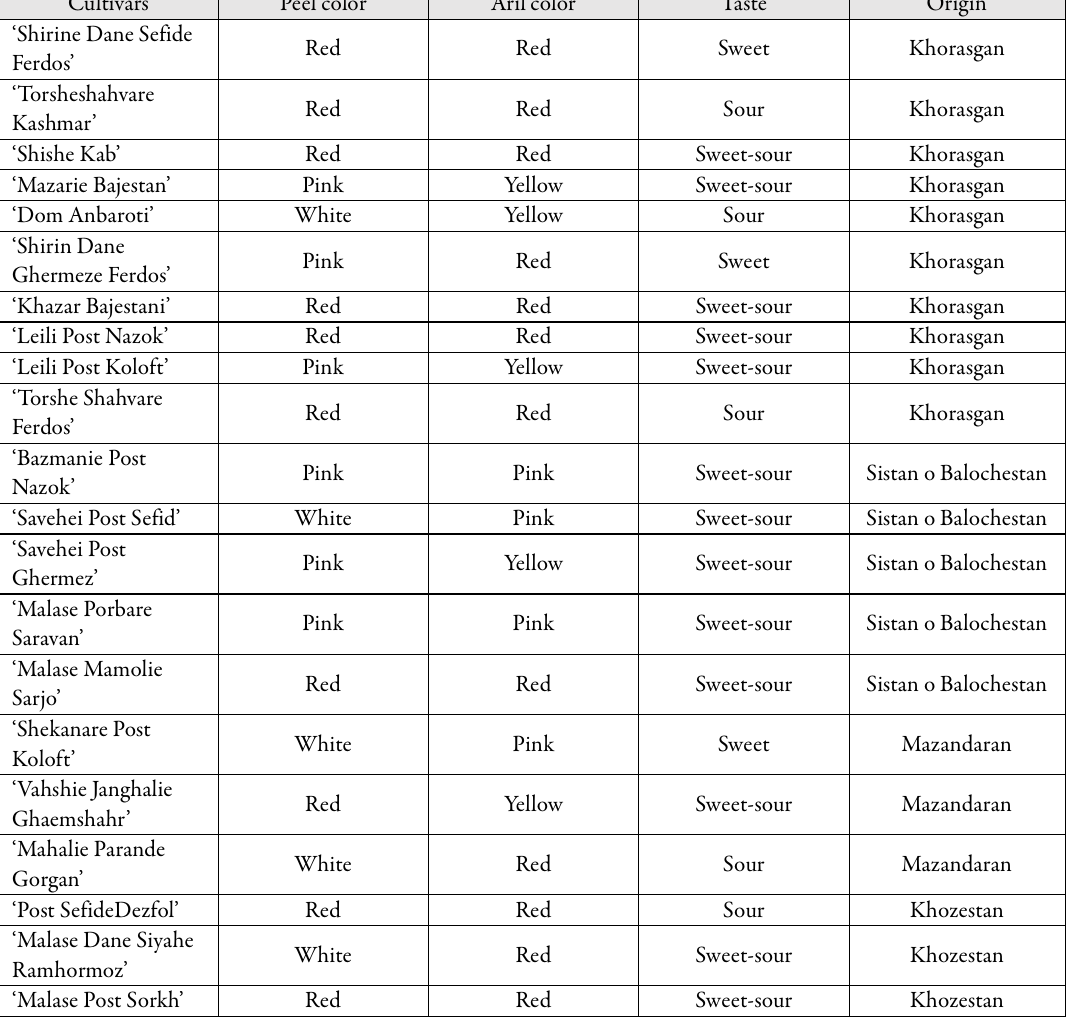
Table 5. The name, peel color, aril color, taste and origin of 31 pomegranate cultivars in Iran (Nemati et al .,